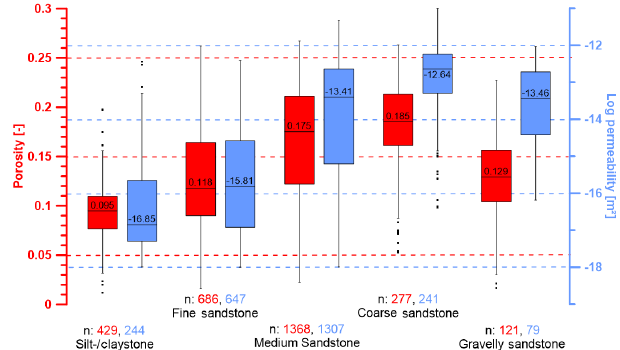
Figure 3. Porosity and permeability data measured on core samples of 16 boreholes (Bär et al., 2013; Bär and Sass, 2015). Values inside the boxes show the median. n: Number of